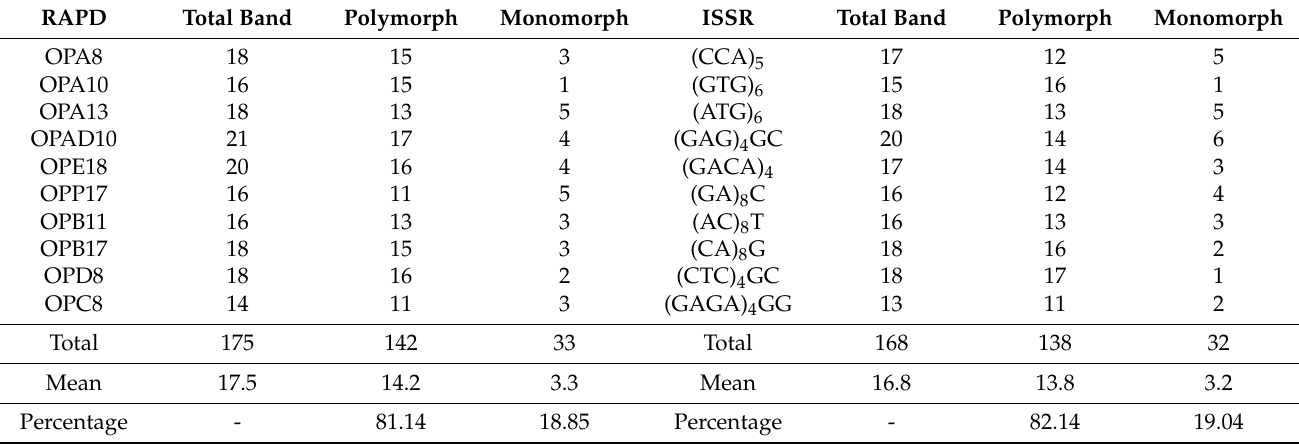
Table 4. Different bands produced by each primer of RAPD and ISSR for populations of Meloidogyne javanica